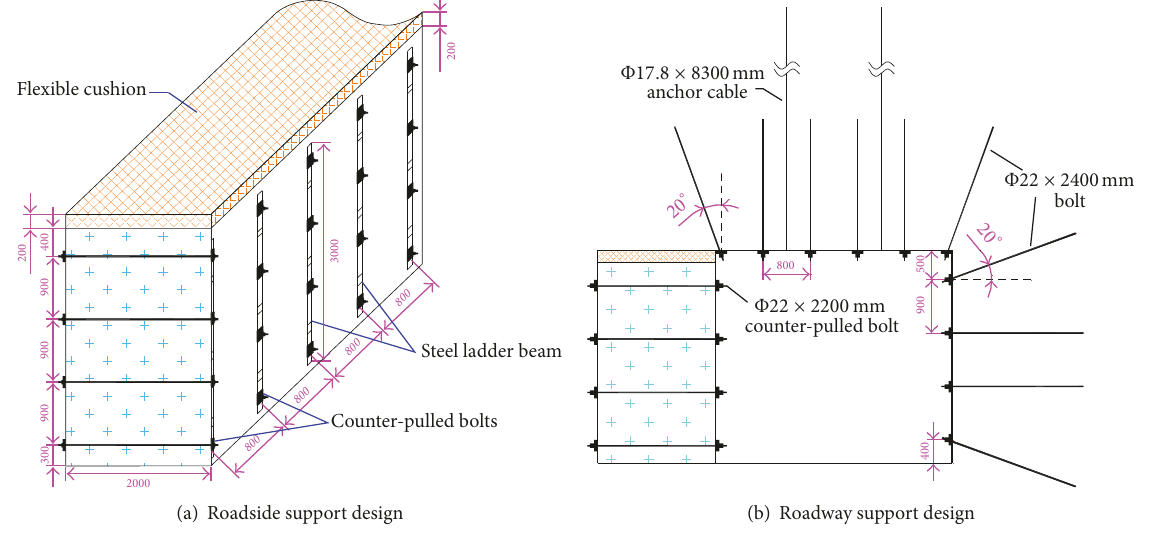
Figure 14: Roadway support design